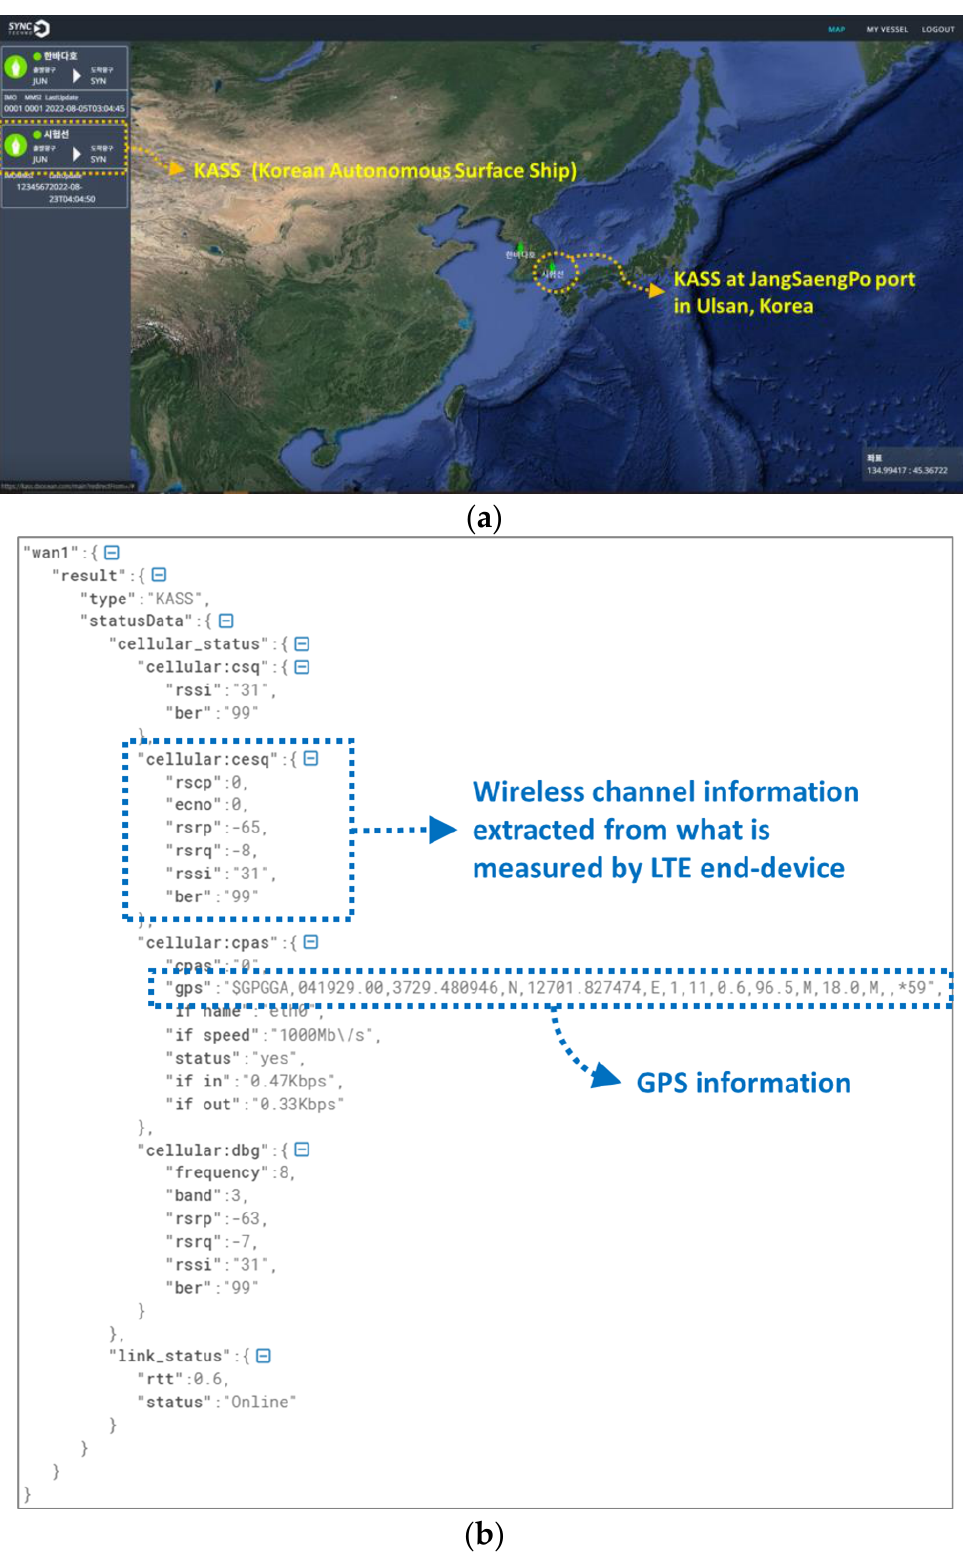
Figure 15. Experiment outcome of test scenario 3 ( a ) DX Ocean ™ software screenshot ( b ) Sample of ISP#1(LTE) wireless channel status information collected from the MRGW and stored at DX Ocean™ (onboard equipment and cloud-based on-land data hub).